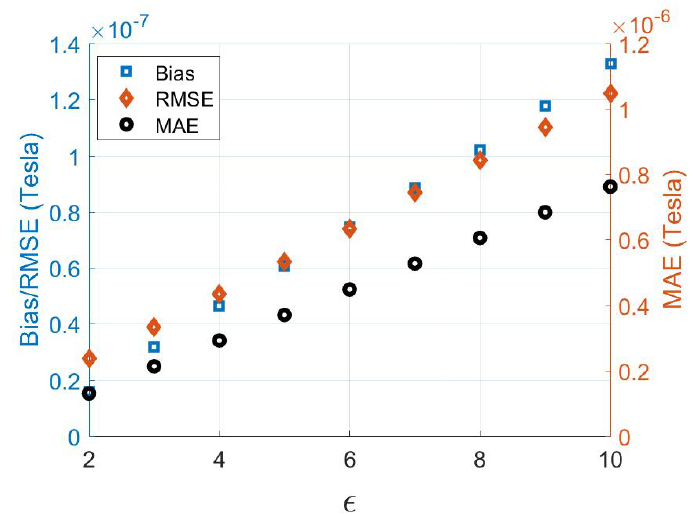
Figure 11. Bias, MAE and RMSE of the estimated ˜ B